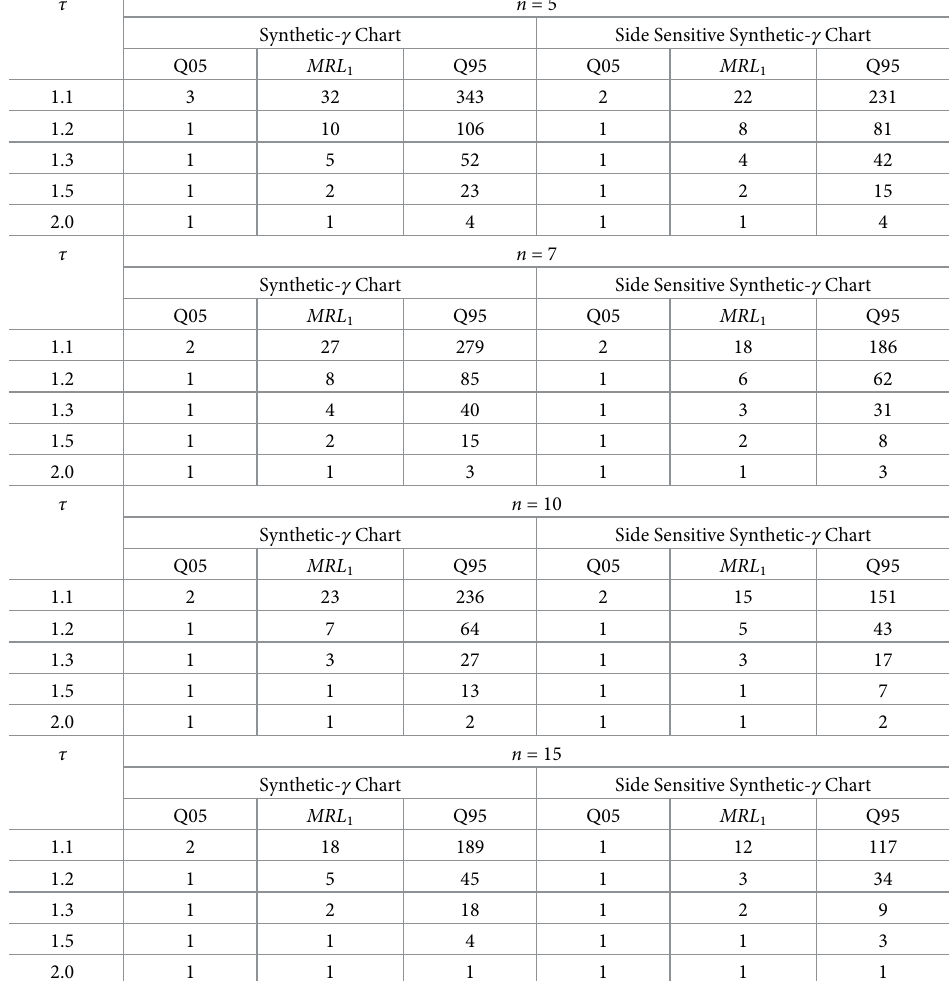
σ pd = γ pd × μ pd , which provides additional evidence that the process can be monitored by detecting changes in γ . pd Table 11 (left) shows a Phase I dataset of m = 20 samples, each with a sample size n = 5. � X ; S and ^ g denotes the sample mean, standard deviation and coefficient of variation, k k k